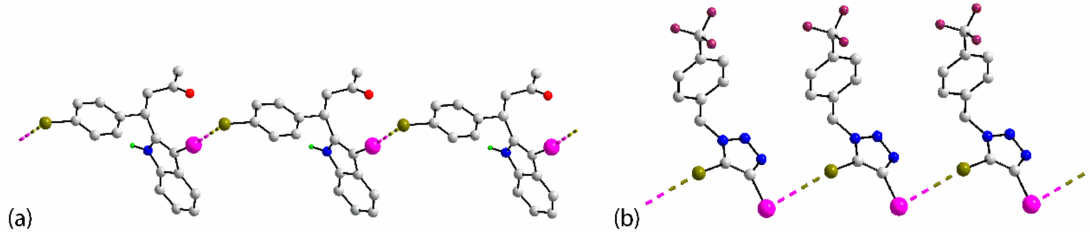
Figure 6. One-dimensional, linear chains in the crystals of ( a ) 10 and ( b ) 14 . It was noted above for the zero-dimensional aggregate formed in co-crystal 9 that the magnitudes of the C–I · · · Br and C–Br · · · I angles were not greatly dissimilar. This observation is evident from the data collated in Table 1 for 12 [52], where the angles differ by less than 1 ◦ , Figure 7a, 13 [53], 15 [55], 17 [57] and 18 [58]; three independent molecules comprise the asymmetric unit of 18 and two of these self-assemble into a linear chain. The approximate linearity and near equivalence of the C–I · · · Br and C–Br · · · I angles rule out halogen bonding via a type-II interaction; it is likely these contacts have significant dispersion contributions (see below). A variation to the above is noted in the linear chain formed in the crystal of 20 [60]. Here, the two iodide and two bromide atoms of the centrosymmetric molecule engage in I · · · Br interactions, with the iodide being the electrophilic centre. The result is the formation of 10–membered { · · · IC 3 Br} 2 synthons and a linear tape, as highlighted in Figure 7b.